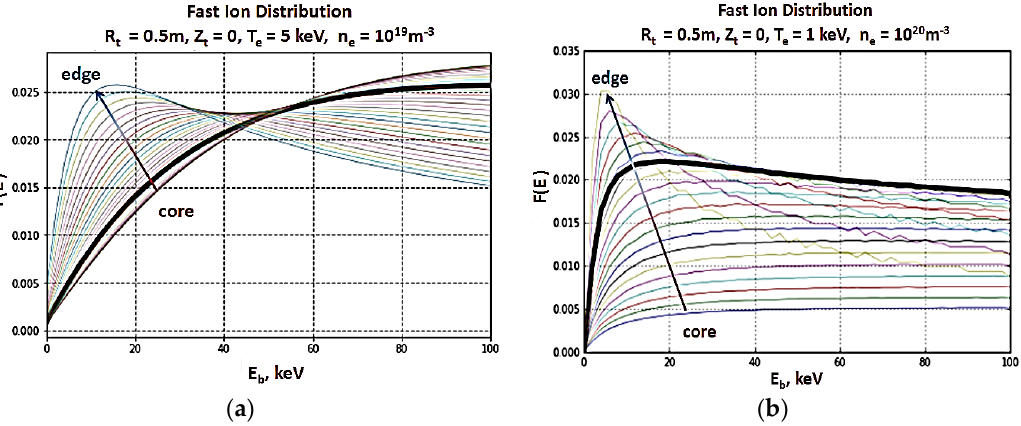
Figure 5. Fast ion energy distribution (black) formed as a result of injection of deuterium beam along the magnetic axis of FNS-ST tokamak (R t = 0.5 m, Z t = 0); plasma density ne = 1 × 10 20 m − 3 , beam energy E b = 100 keV: ( a ) plasma temperature Т e = 5 keV; ( b ) Т e = 1 keV. Thin colored lines correspond to partial distributions for different radial layers (Ψ).